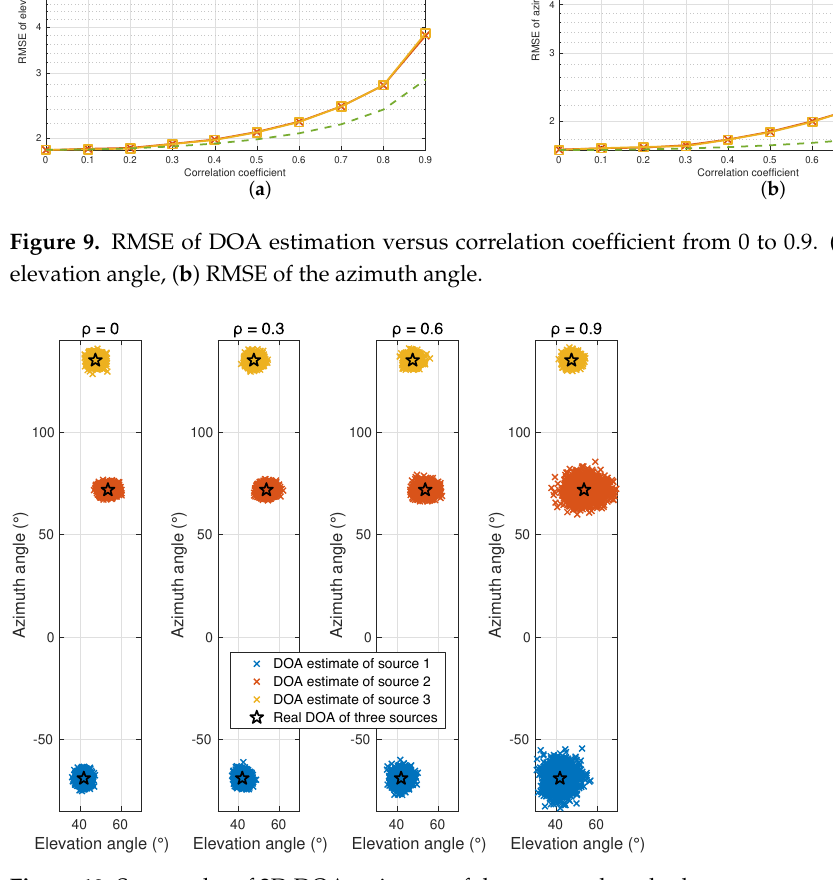
Figure 10. Scatter plot of 2D DOA estimates of the proposed